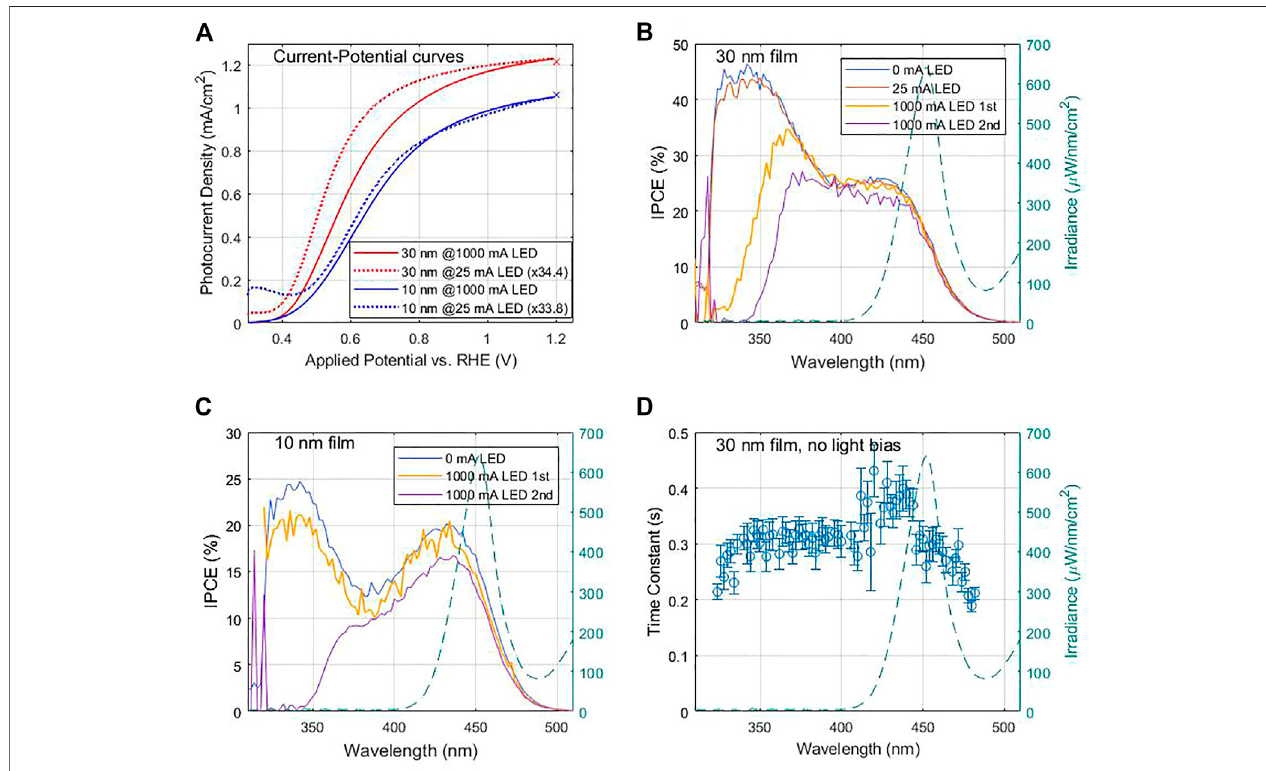
FIGURE9| Measurementsof30and10 nmthickBiVO 4 samplesmeasuredinaneutralbuffersolutionwithaholescavenger;detailsin(Graveetal.,2021). (A) J ph - U curves for 30 nm (blue) and 10 nm (red) thicknesses, under white-light LED bias of ∼ 1 sun (solid) and low-intensity (dotted). The x ’ s at 1.2 V indicate the applied potential where the IPCE was measured as well as the resultant integrations of Eq. 3b (B) IPCE spectra for the 30 nm fi lm at various light intensities. The measurement sequence is described in the text. The LED spectrum is overlaid on the right y -axis (teal color). Zero-bias IPCE data obtained from (Grave et al., 2021). (C) IPCE spectra for the 10 nm fi lm at various light intensities. The measurement sequence is described in the text. The LED spectrum is overlaid on the right y -axis (teal color). Zero-bias IPCE data obtained from (Grave et al., 2021). (D) Fitted time constant of the step-response vs. wavelength, measured during the IPCE measurement without light bias, for the 30 nm fi lm. The LED spectrum is overlaid on the right y -axis (teal color).